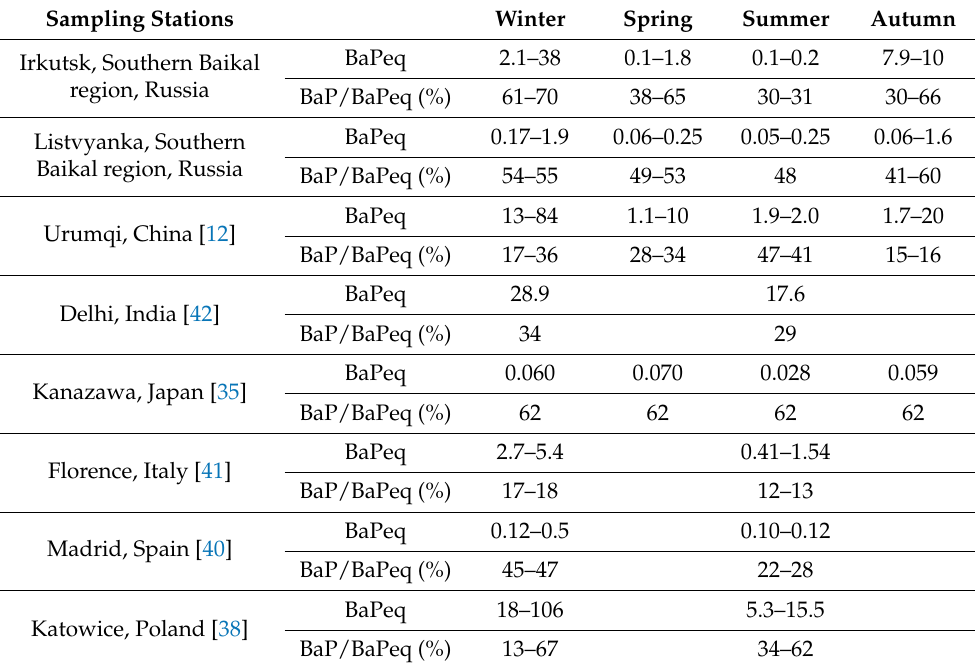
Table 4. Concentrations of BaPeq (ng/m 3 ) and BaP/BaPeq (%) in the atmospheric air by seasons in different regions of the